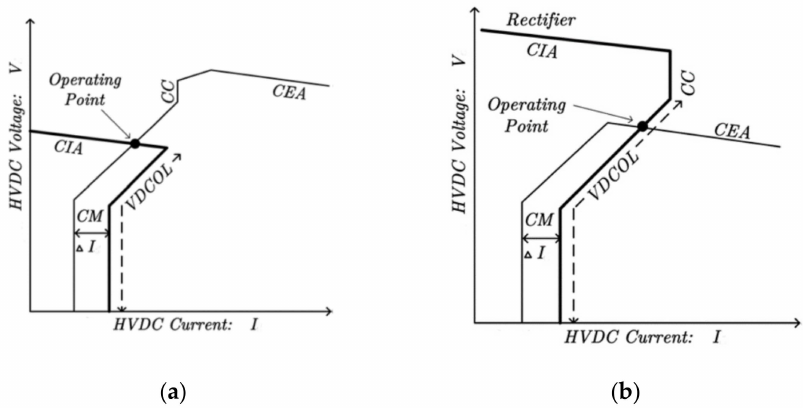
Figure 4. HVDC LCC characteristic curves under AC fault conditions: ( a ) rectifier AC fault, ( b ) inverter AC